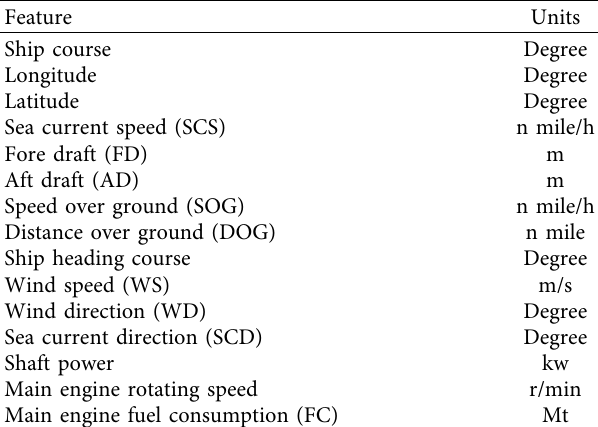
Table 1: Information related to collected